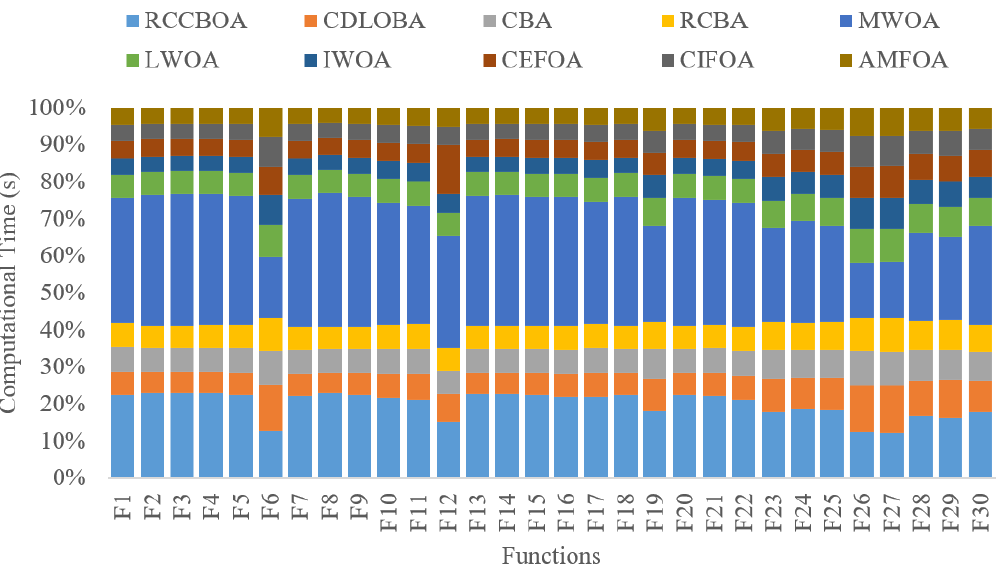
Figure 5. The percentage of computational time taken by RCCBOA and other advanced algorithms.